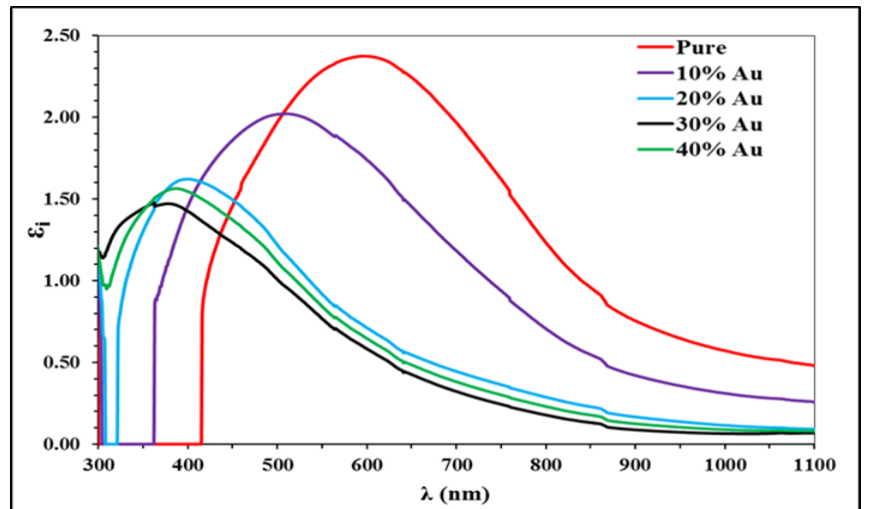
Fig. 15: The real part of dielectric constant for pure WO and 40)% thin films as a function of wavelength.